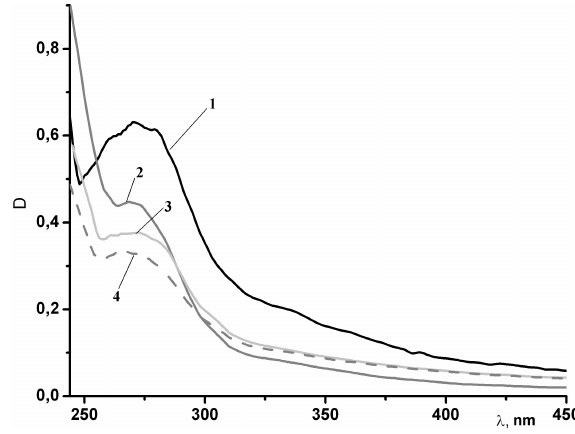
Fig. 2. Absorption spectra of supernatant of wool samples obtained from healthy mouse (1) and from mice with cancer tumor 1 cm (2), 2 cm (3) and 3 cm